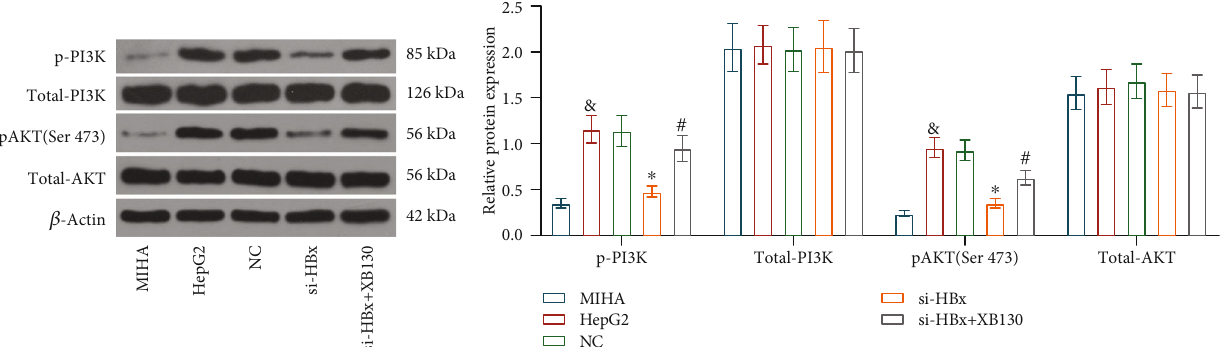
Figure 7: HBx activates the PI3K/AKT pathway by upregulating XB130, which is determined by Western blot analysis. ∗ # & p < 0 : 05 .